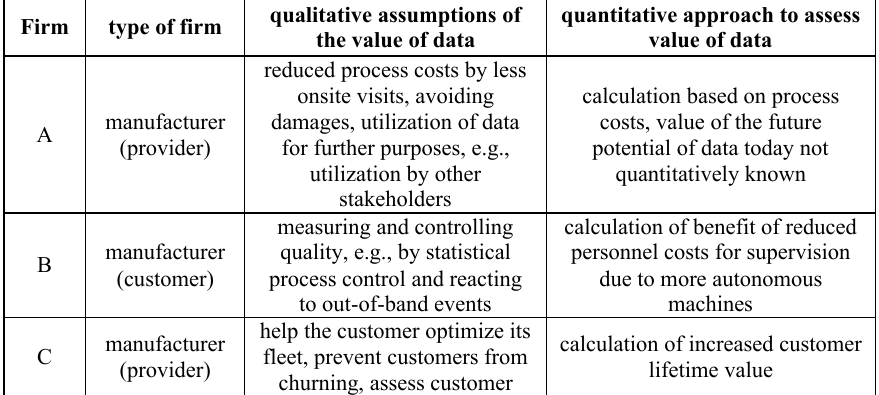
Table 1. Data valuation methods found in the field